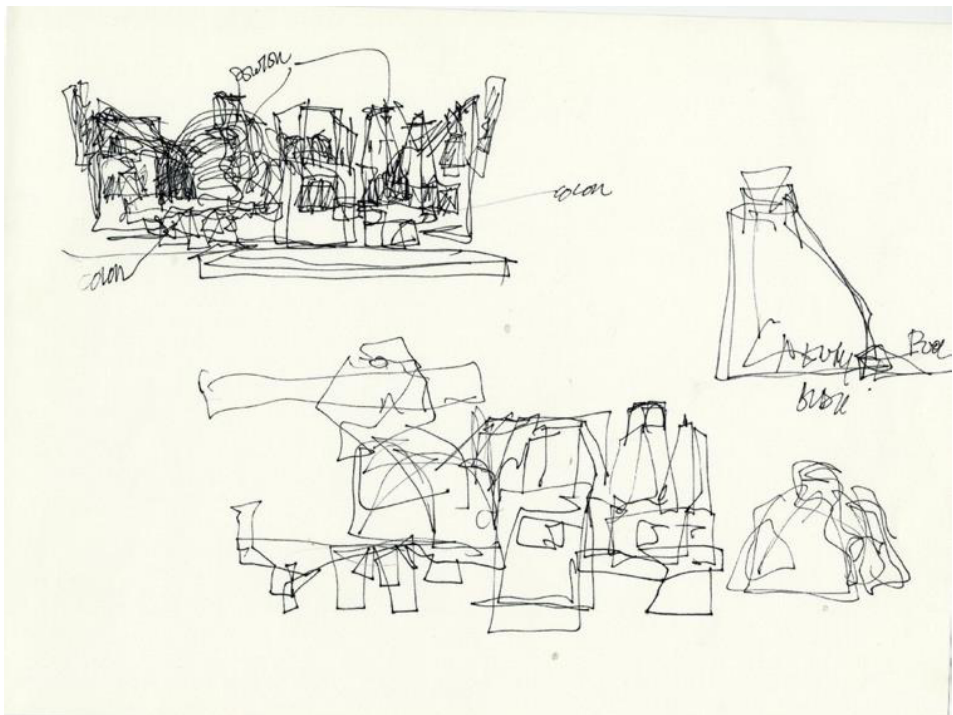
Figure 3. Frank Gehry, project sketch for Chiat Residence, Sagaponeck, New York, 1986 © Frank O. Gehry. Frank Gehry papers, Series I: Architectural Projects, Getty Research Institute, Los Angeles, CA. Digital image courtesy of the Getty Research Institute Digital Collections.